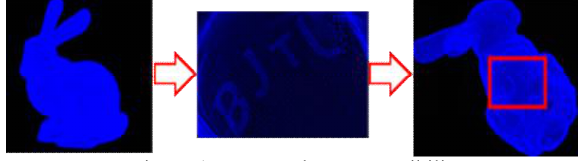
Figure 4.Watermark